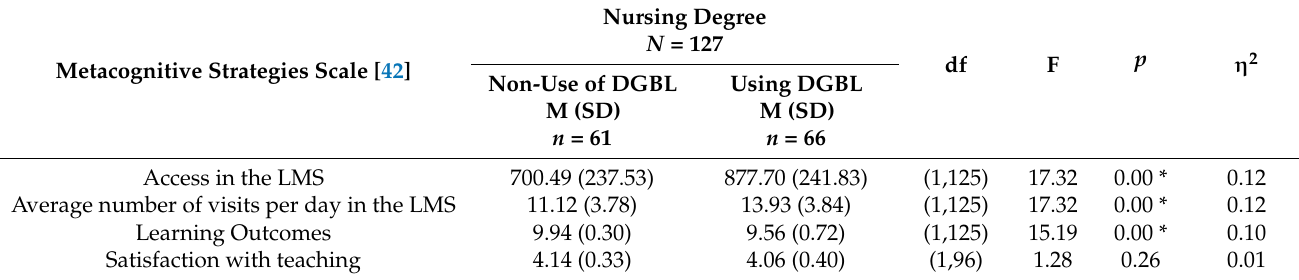
Metacognitive Strategies Scale [42]